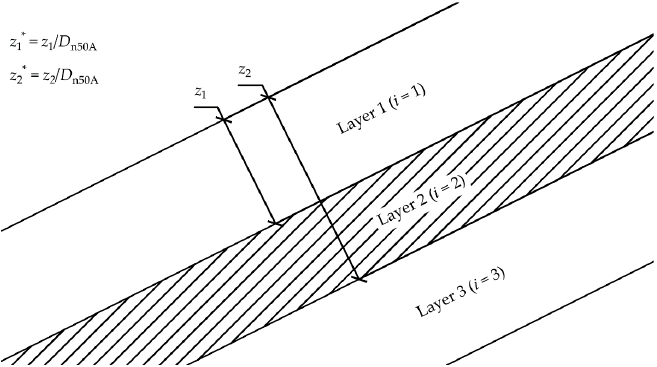
Figure 15. Example of the definition of the relative depth z 1* and z 2* for i = 2 in Equation (6) with D n50A as the nominal size of the armor stones.